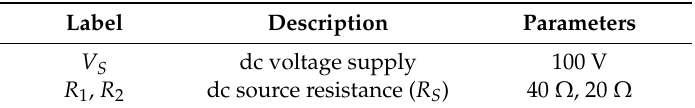
Table 2. Resistive dc source parameters.